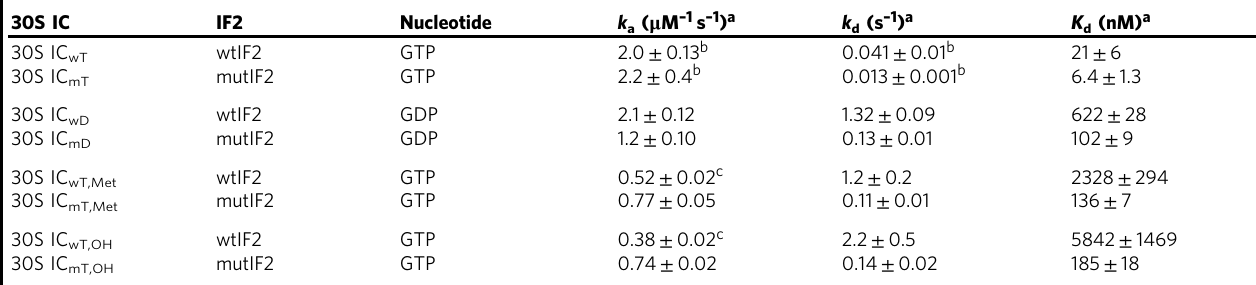
Table 1 Association rate constant ( k a ), dissociation rate constant ( k d ), and dissociation equilibrium constant ( K d ) for the interaction of IF2 and the 30S